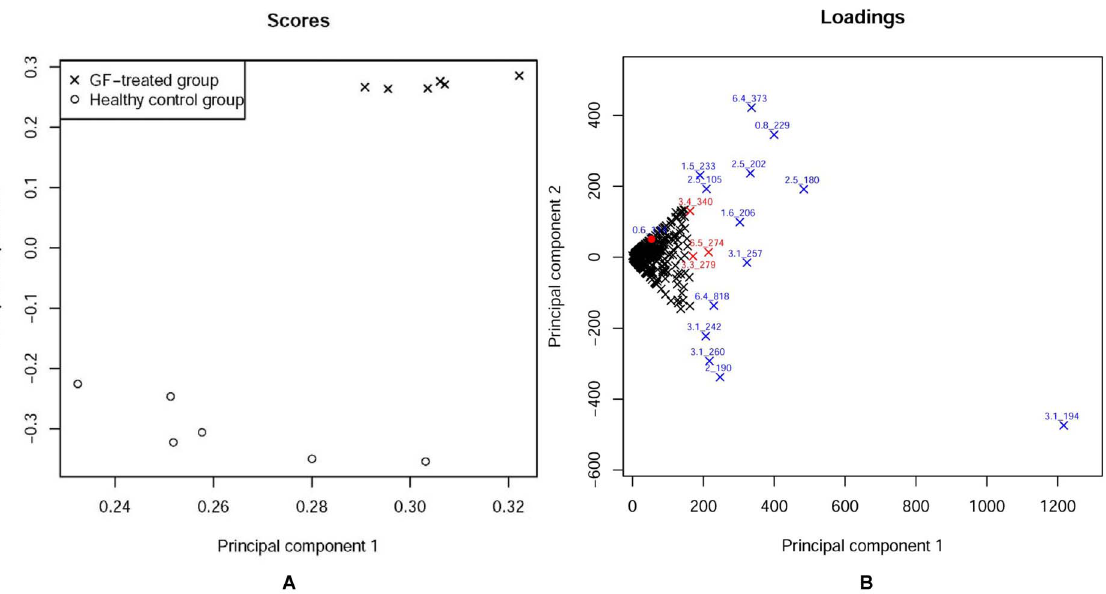
Figure 4. The PCA score plot and corresponding loading plot for the metabolic profiles of the GF-treated group and the healthy control group: (A) the score plot showing the separation between the GF-treated group (X) and the healthy control group (o). (B) Loading plot for potential biomarker recognition. The metabolites marked by the blue X far away enough from the origin are identified as the potential biomarkers. The metabolites marked by red X are difficult to determine whether they are the potential biomarkers. The red dot represents the retention time-m/z pair 0.6_114.